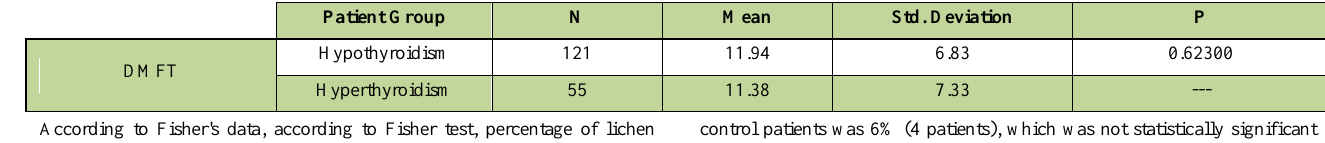
Table 3. DMFT levels in two groups of hypothyroidism and hyperthyroidism.